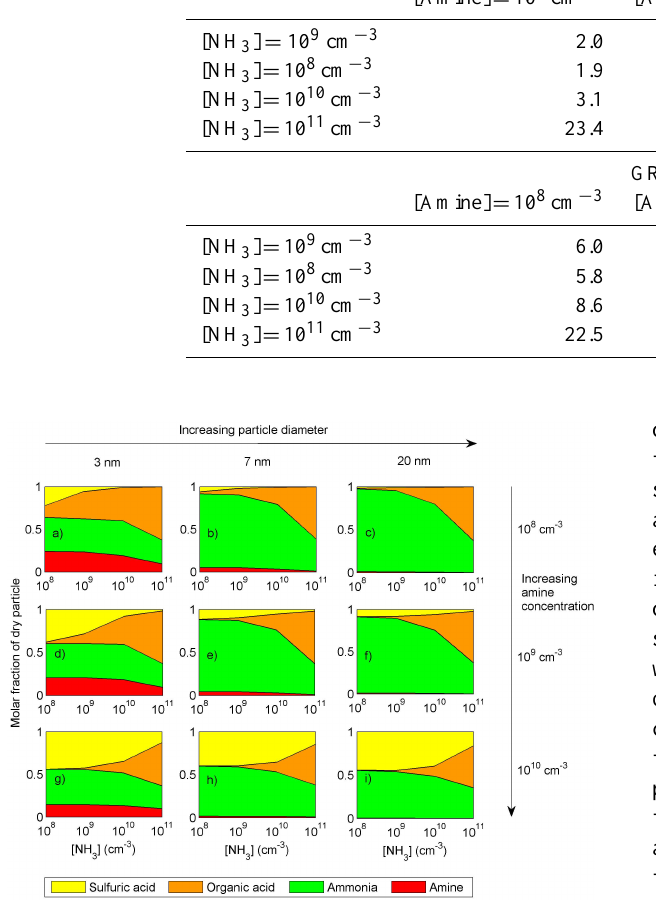
Fig. 5. Dry particle molar fractions of particles at 3nm (a, d, g) , 7nm (b, e, h) and 20nm (c, f, i) as a function of ammonia concen- tration at amine concentrations of 10 8 cm − 3 (a, b, c) , 10 9 cm − 3 (d, e, f) and 10 10 cm − 3 (g, h, i) . Concentration and saturation vapour pressure of organic acid were set to 3 × 10 8 cm − 3 and 10 − 6 Pa. ble 1). Sulfuric acid concentration (10 6 cm − 3 ) , RH (40%) and